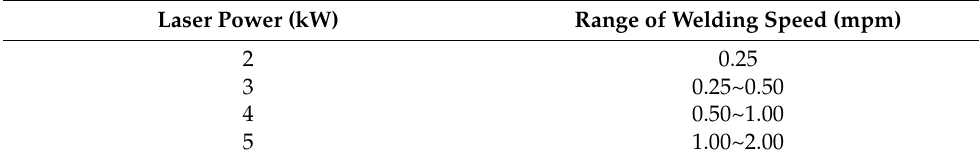
Table 5. Condition range for 1-pass welding of 6 mm 9% nickel